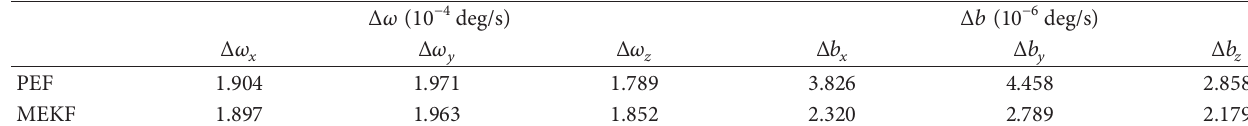
Table 3: The maximum absolute steady estimation errors.